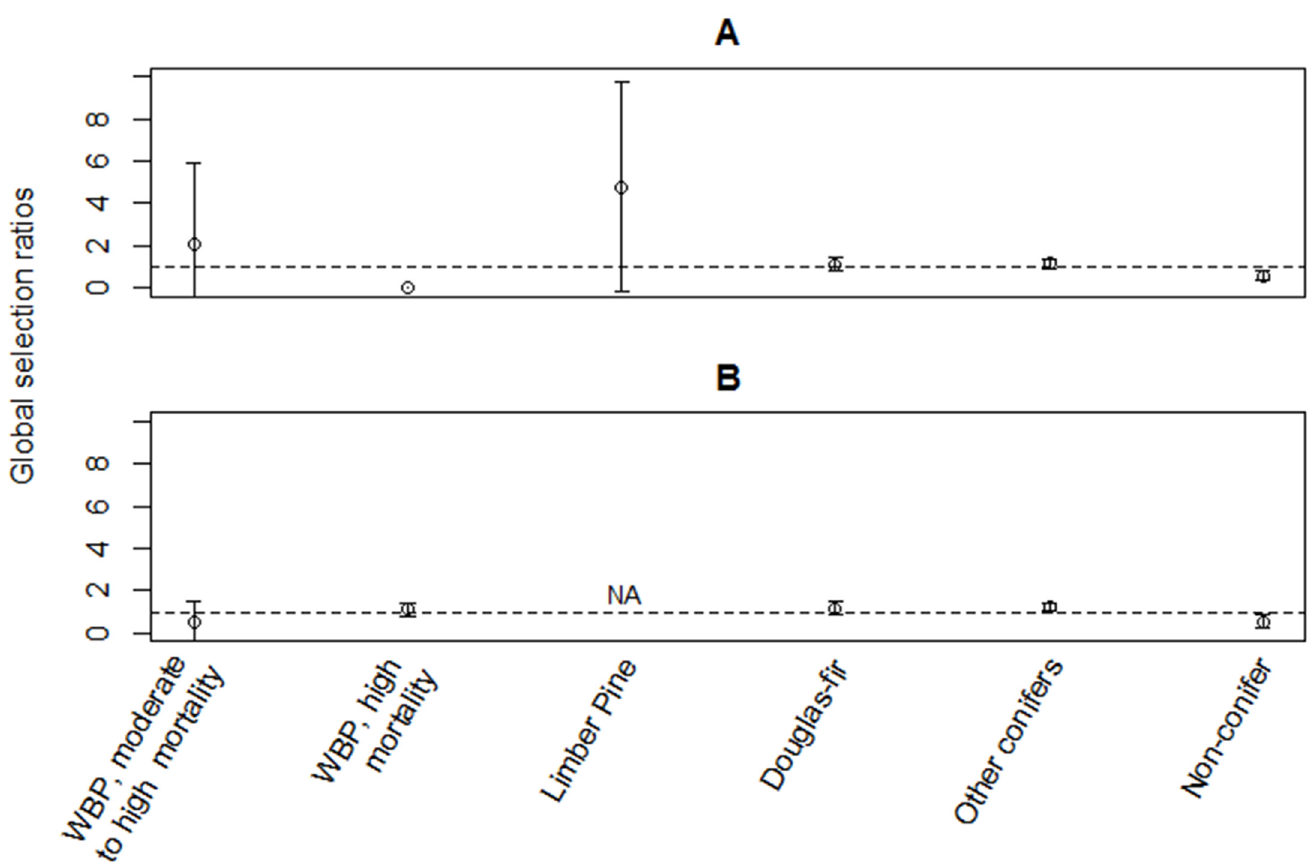
Fig 4. Habitat selection within the home range. Clark ’ s nutcracker selection of the habitat at locations from within the home range in ( A ) 2011, all nonbreeding birds and ( B ) 2012, breeding birds only. The Manly selectivity measure ( ± Bonferroni 95% confidence intervals (CI ’ s)) was used to determine if habitats were used in higher proportion than the proportion available ( > 1), used in the same proportion as the proportion available (CI ’ s include 1), used in lower proportion than the proportion available (0 < X < 1) or never used (0). Whitebark pine is abbreviated as WBP.